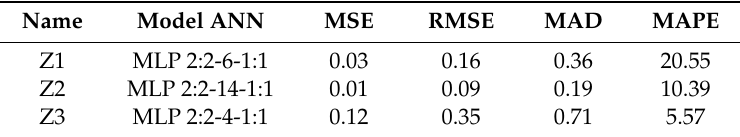
Table 3. The results of validation for the strawberry neural models. MSE: mean square error; RMSE: root mean square error; MAD: mean absolute deviation; MAPE: mean absolute percentage